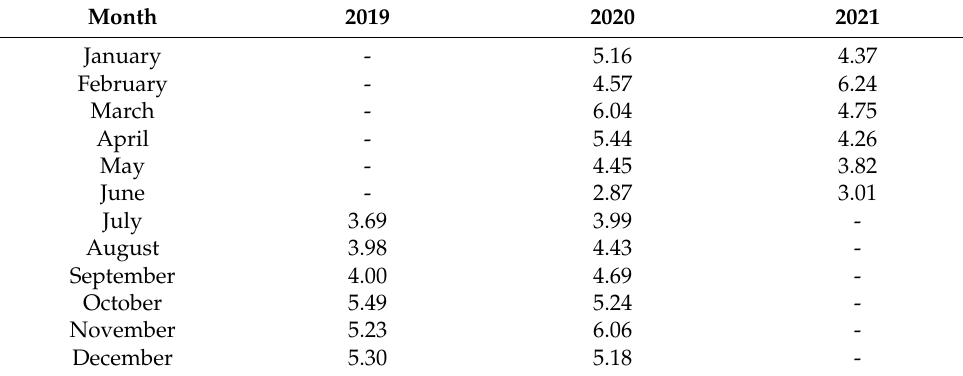
Table 5. Monthly average irradiation in the plane of the carport (kWh/m 2 /day).